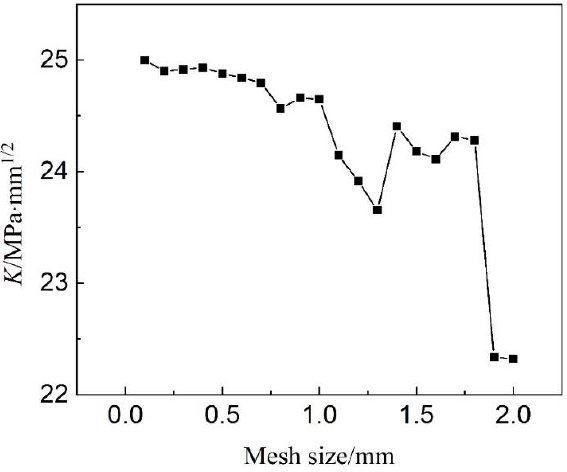
Figure 5. The influence of mesh sizes on the coefficient K of the SIF.